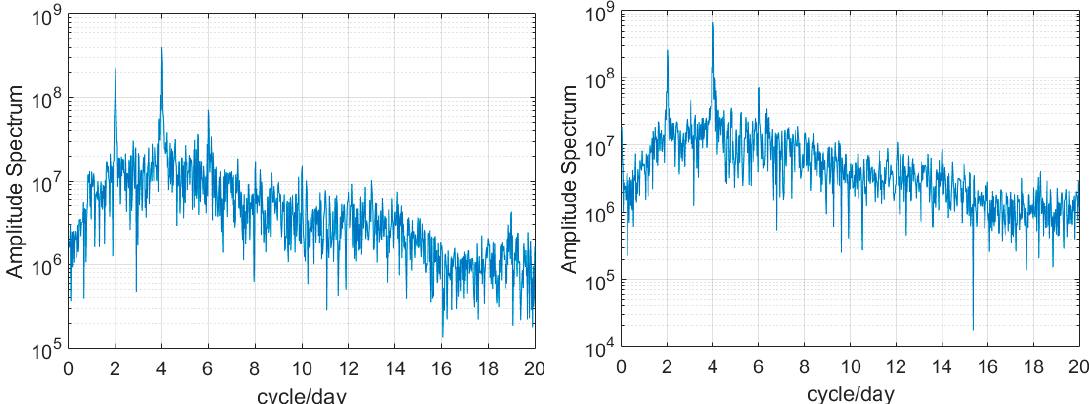
Figure 3. Spectrum of two 2-h prediction residual sequences for G25 and G30.